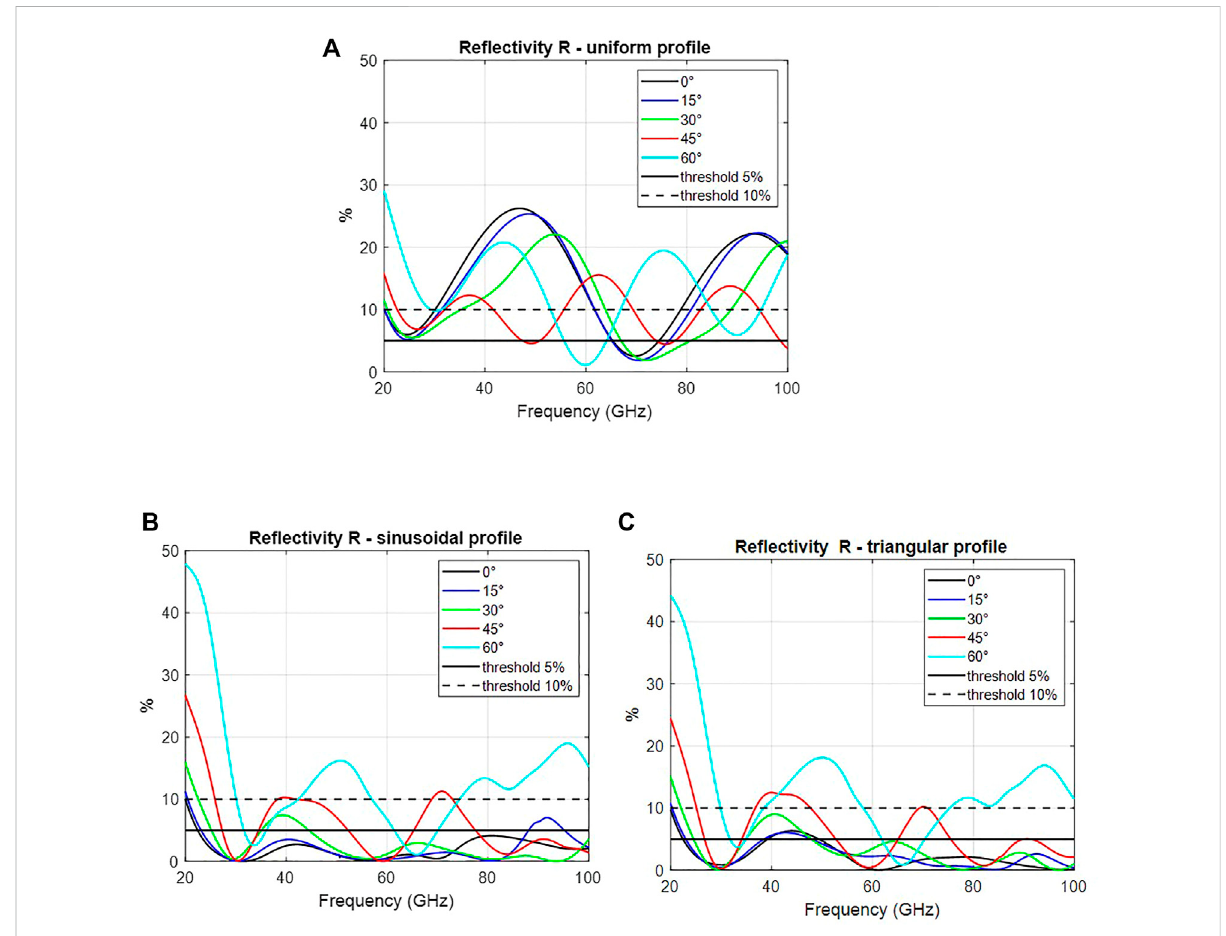
FIGURE 4 Angular dependence of re fl ectivity R (A) uniform pro fi le (B) sinusoidal pro fi le (C) triangular pro fi le.